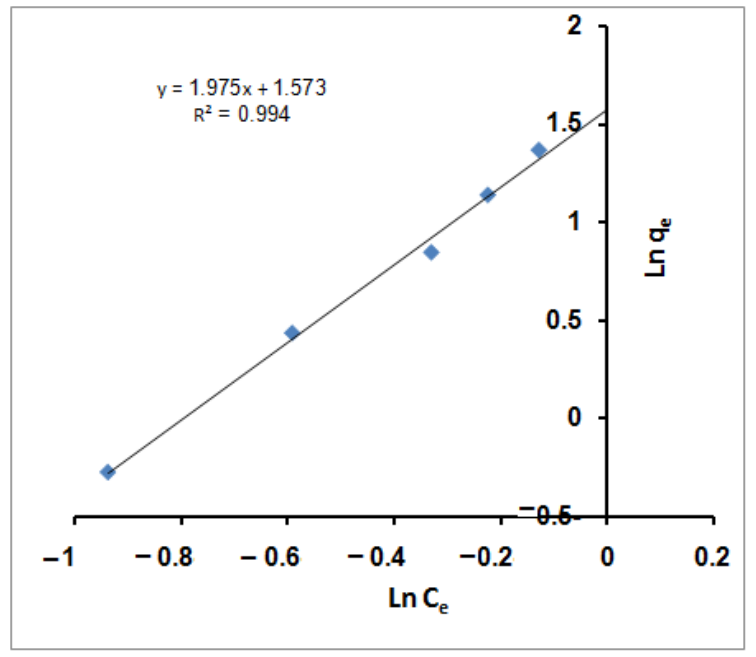
predicts that the MB molecules concentration on the sorbents will increase as long as there results. Furthermore, the correlation coefficient (R 2 ) value (0.994) demonstrated that the constants n f (0.506) and K F (4.822) are estimated from the slope and intercept of the linear plot. From the assessed value of n f , it was found that n f < 1 dictated non-favorable sorption for MB molecules with the SPGMA particles [71].